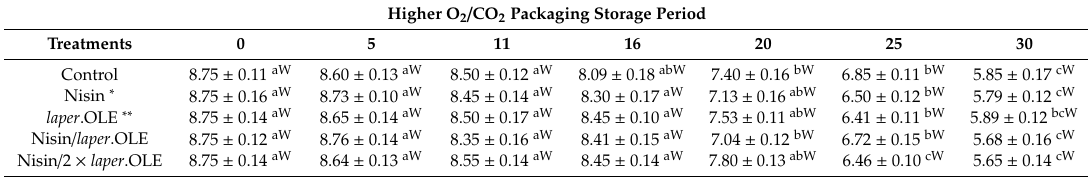
Table 2. Warner-Braztler shear force (WBSF) (value = mean ± SD) on camel steaks treated with combined laper .OLE and nisin during storage under modified atmosphere packaging